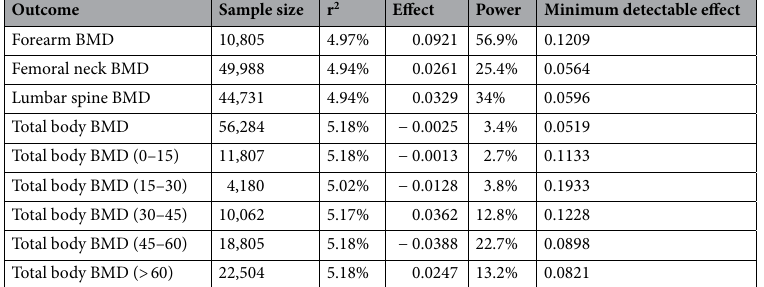
Table 1. Sample size of BMD groups and statistical power of MR analysis. BMD bone mineral density, MR Mendelian randomization, r2 the proportion of phenotypic variation explained by genetic variants.